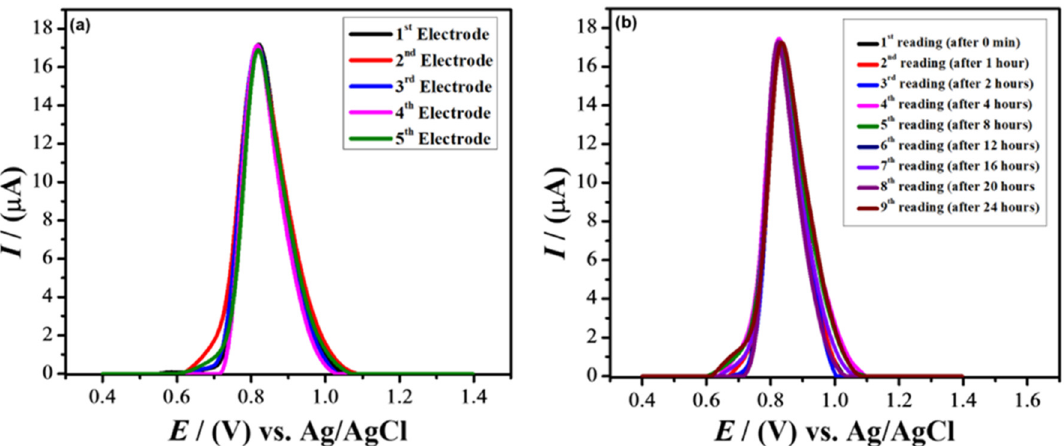
Figure 6. ( a ) SWVs of NBS showing the reproducibility of the designed sensor. ( b ) SWVs of NBS showing repeatability of the designed